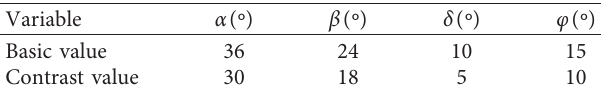
Table 3: Basic value and the corresponding contrast values of these variables.